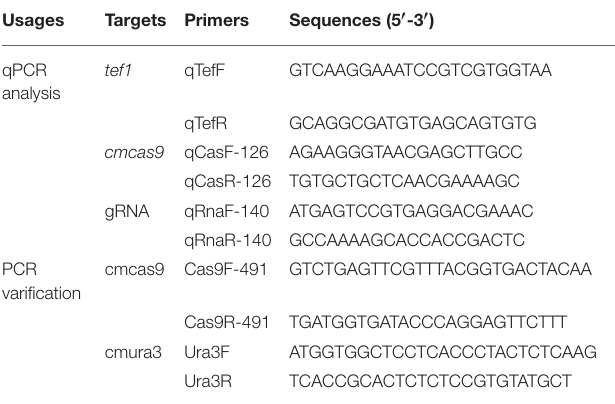
TABLE 3 | Primers for PCR and